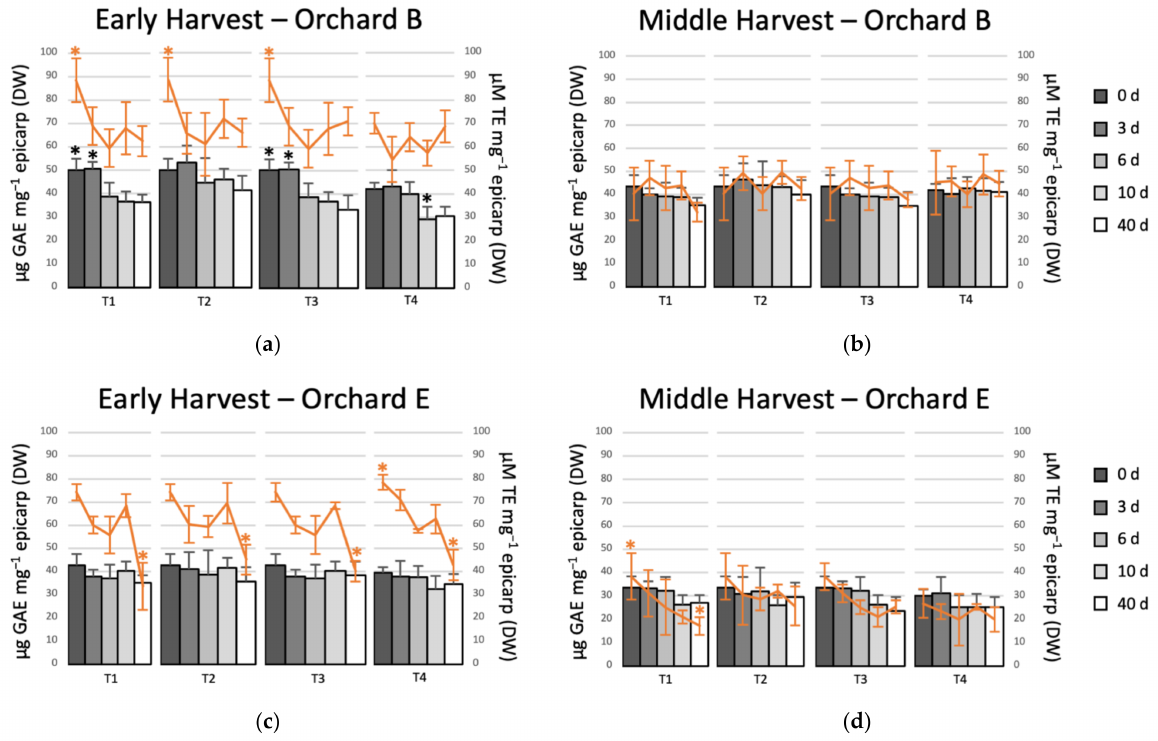
Figure 3. Evolution of the total phenolic content (TPC) expressed as gallic acid equivalents (GAE) and the antioxidant capacity (AC) expressed as trolox equivalents (TE) of avocado fruit epicarp during different postharvest treatments. ( a ) Early harvest orchard B; ( b ) middle harvest orchard B; ( c ) early harvest orchard E; and, ( d ) middle harvest orchard E. T1: 40 d in regular air (RA) at 5 ◦ C; T2: 40 d in controlled atmosphere (CA) 4 kPa O 2 and 6 kPa CO 2 at 5 ◦ C; T3: 10 d in RA at 5 ◦ C plus 30 d in CA 4 kPa O 2 and 6 kPa CO 2 at 5 ◦ C; and, T4: 5 µ M MeJA plus 10 d in RA at 5 ◦ C plus 30 d in CA 4 kPa O 2 and 6 kPa CO 2 at 5 ◦ C. TPC is represented by bars and AC by lines. The asterisk showed statistical differences in each treatment (95%